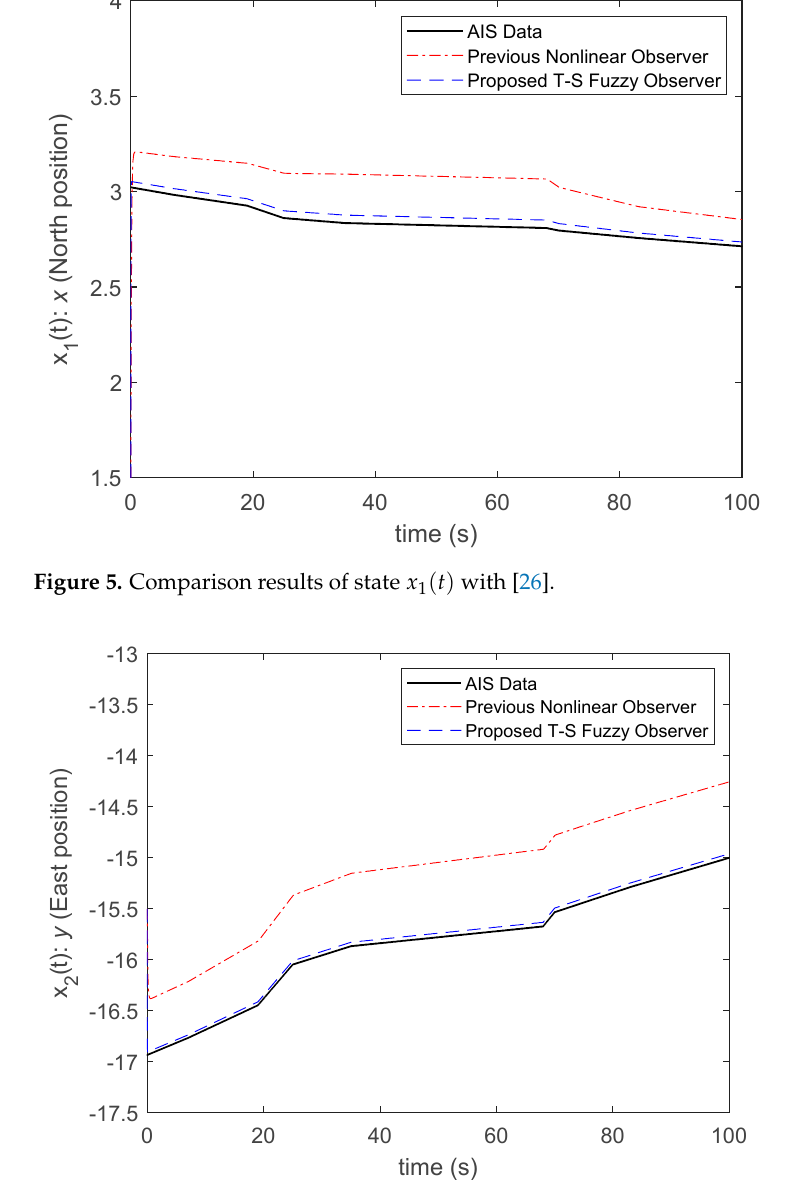
x t with [26]. 2 x t with [26]. Figure 6. Comparison results of state x ( t ) with 2 2